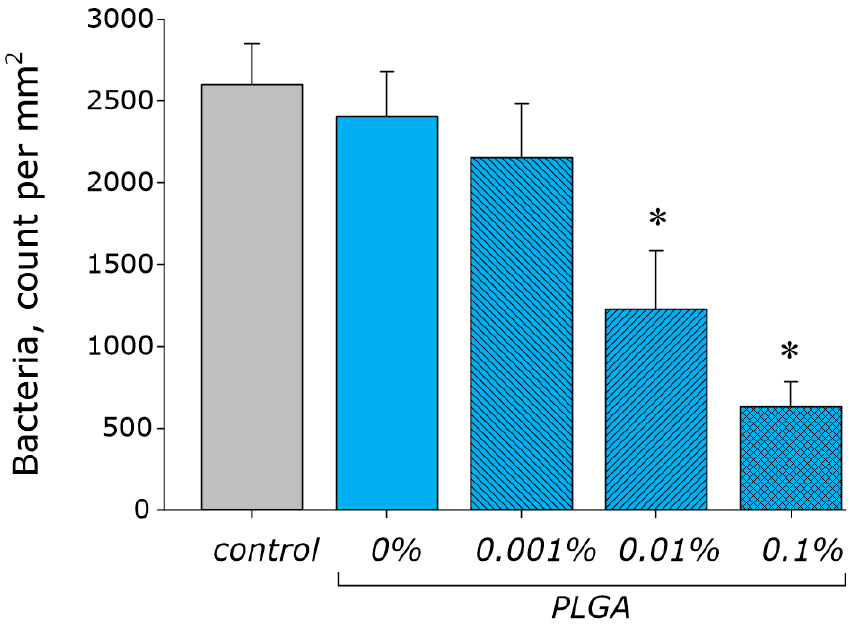
Figure 9. Influence of composite material based on PLGA and Al 2 O 3 NPs on the growth and de- velopment of E. coli. * — significant difference at 5% level in comparison with the control ( p < 0.05). development of E. coli. *—significant difference at 5% level in comparison with the control ( p <